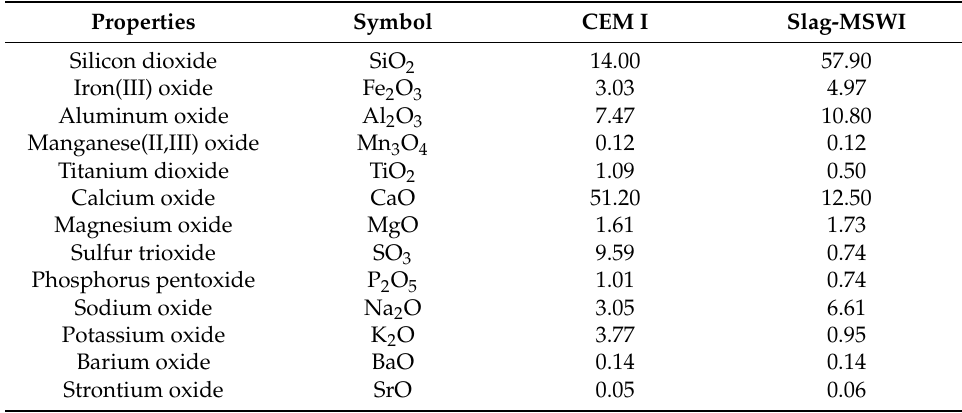
Figure 3. Analyzed materials: a ) cement (CEM I), b ) municipal solid waste incineration (MSWI) raw slag and c ) ground slag (authors’ photo). Table 2. Content of oxides (%) in the tested materials.